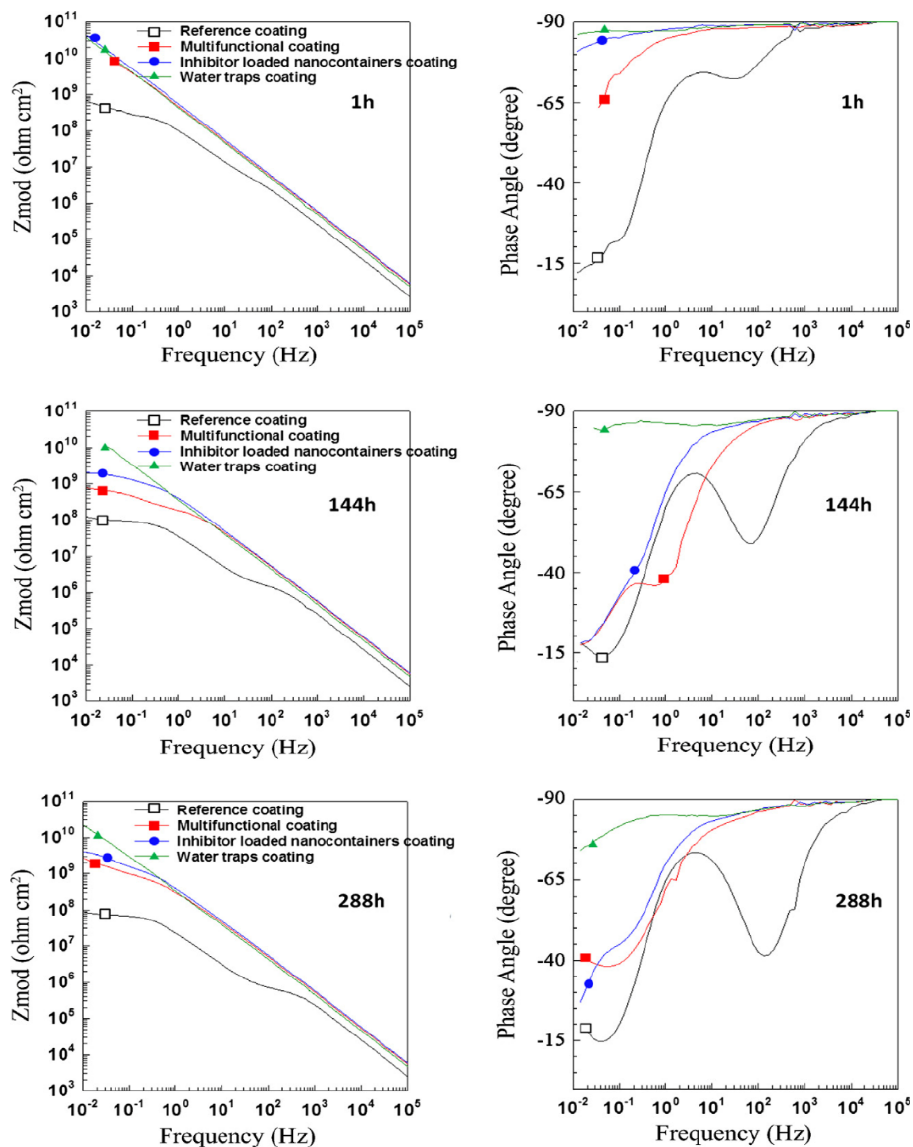
techniques. Figure 22 shows the SVET results of total anodic and cathodic current obtained for the three coatings. One can perceive that the I anodic – I cathodic are close to zero for up to 17 h for the LDH(MBT) sample, and then they start to increase linearly with the time. In the CeMo(MBT) sample, the I anodic – I cathodic increases rapidly up to three hours due to corrosion and then drops to zero for times longer than 20 h due to self-healing.